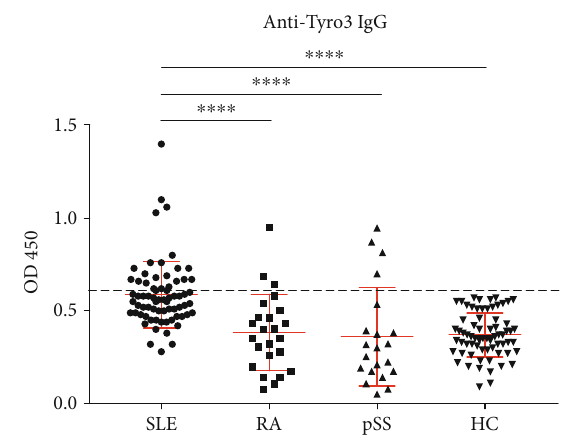
Figure 1: Detection of anti-Tyro3 IgG levels in SLE, RA, pSS, and HCs. SLE: systemic lupus erythematosus; RA: rheumatoid arthritis; pSS: primary Sjögren ’ s Syndrome; HC: healthy